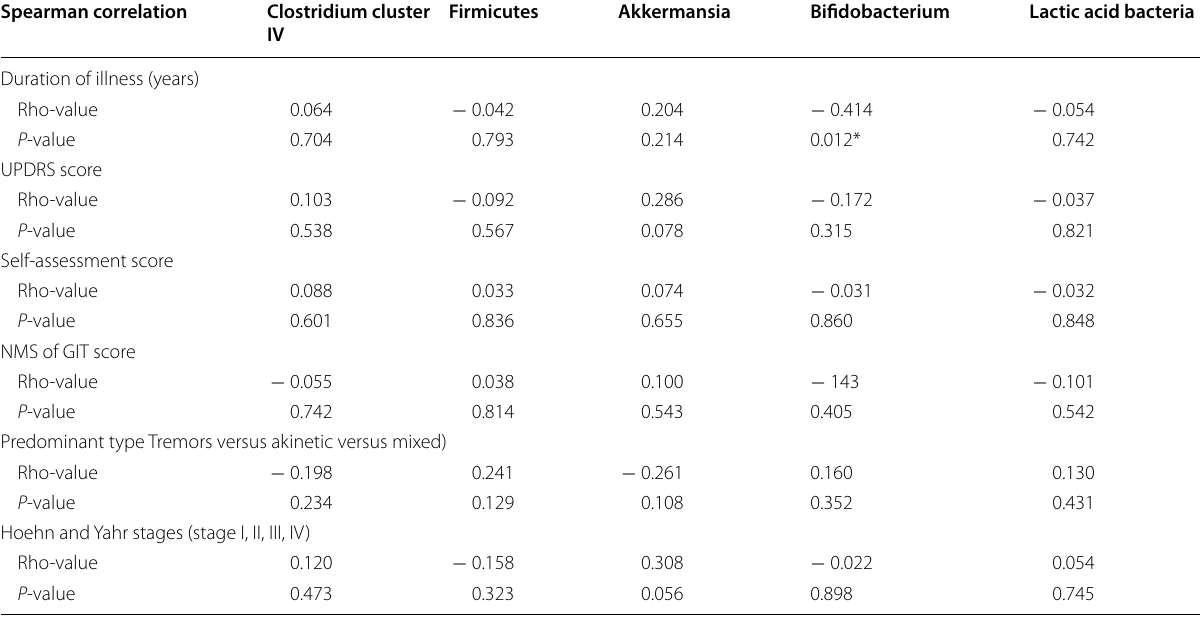
PD Parkinson’s disease, UPDRS score Unified Parkinson’s Disease Rating Score, NMS of GIT score; Non-motor symptoms of gastrointestinal tract score *Correlation is significant P < 0.05 level (2-tailed)